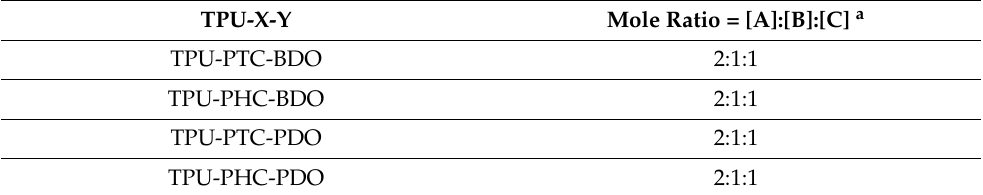
Table 1. Composite of TPU copolymers.